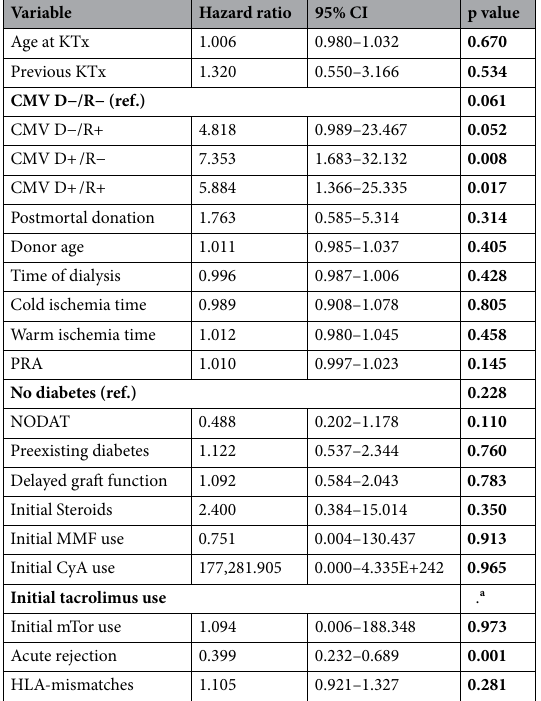
Table 5. Cox regression for co-infection risk factors. KTx kidney transplantation, CMV cytomegalovirus, D/R donor/recipient, PRA panel reactive antibodies, NODAT New onset diabetes after transplantation,